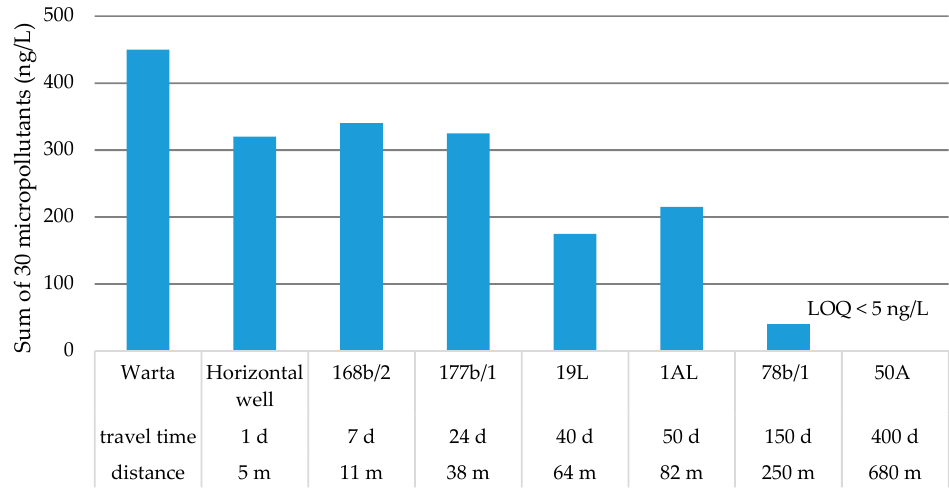
Figure 6. Changes in total micropollutant concentrations along the flow path. Limit of Quantification (LOQ).